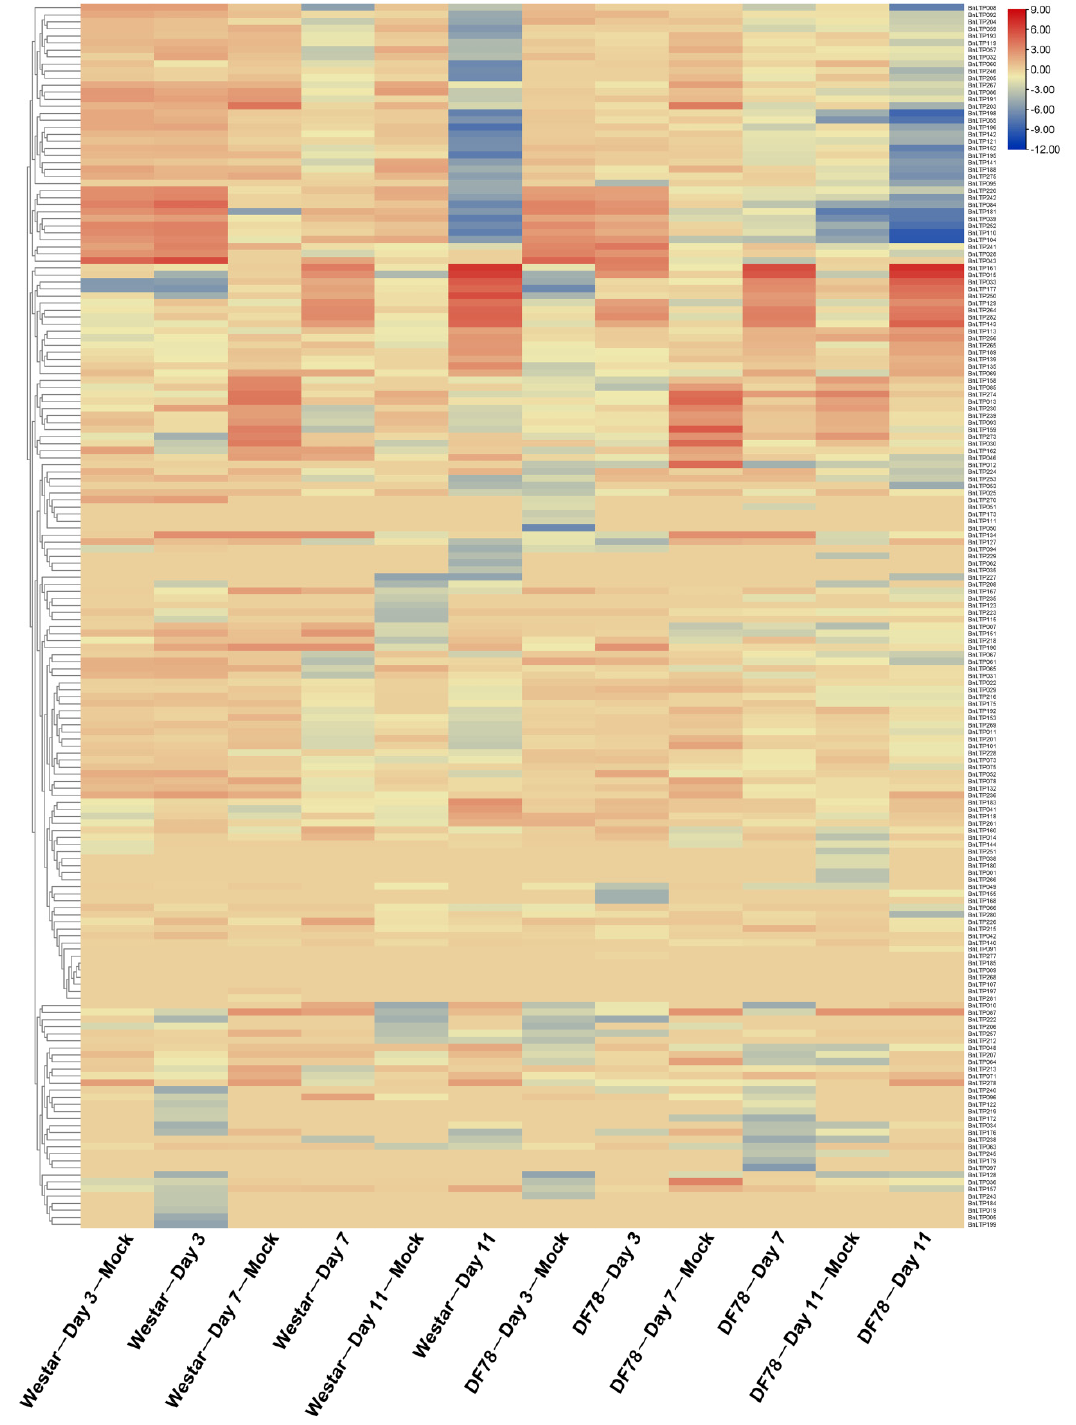
Figure 6. Expression patterns of BnLTP family genes in the cotyledons of rapeseed resistant (DF78) and susceptible (Westar) lines at 0, 3, 7 and 11 days post- L. maculans inoculation.